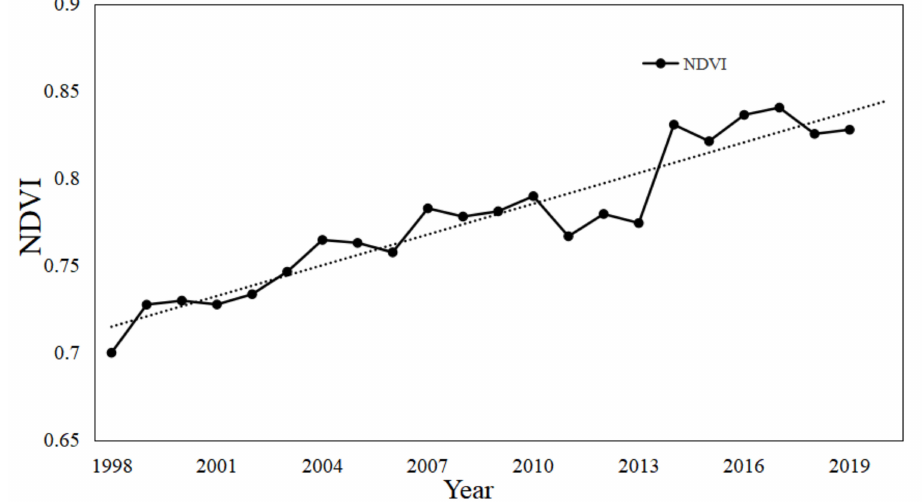
Figure 11. NDVI change at the Wulong Station during the period